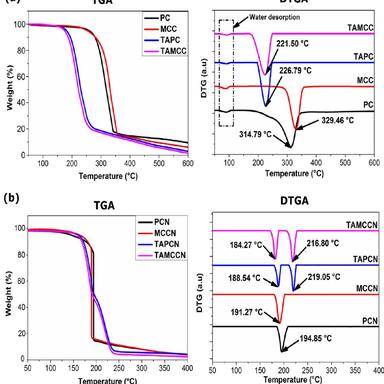
TGA and DTGA thermograms of (a) unmodified precursors and their chemical modified derivatives; (b) functionalized and non-functionalized nitrated polymers.